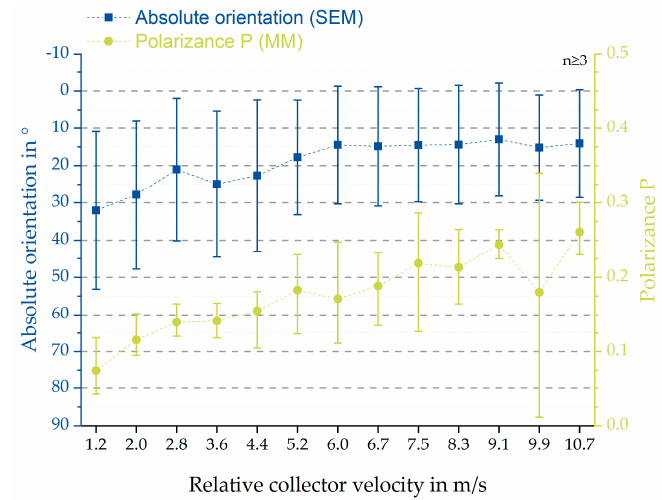
Figure 10. Correlation between polarizance P (resulting from MM measurements) and absolute orientation (measured SEM-based) of the PCL/GT fibre scaffolds. The green circles represent the mean values for the polarizance P with error bars (min. and max.) whereas the blue squares show the results for the absolute orientation with error bars (±SD).